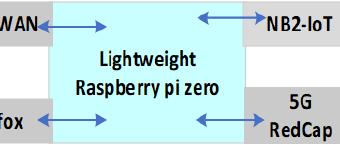
Figure 2. Block diagram of a multihomed LHM-N